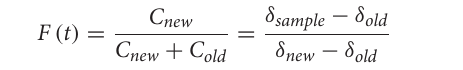
Wheat (W-irr and W-rf)